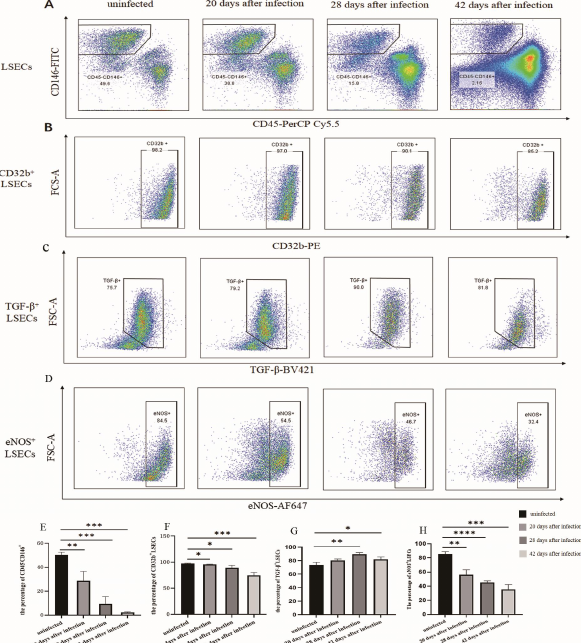
Figure 1. Changes in the LSEC phenotype after being infected with S. japonicum . ( A ) The population of LSECs in hepatic non-parenchymal cells after infection. ( B ) The population of CD32b + LSECs in hepatic non-parenchymal cells after infection. ( C ) The population of TGF- β + LSECs in he- patic non-parenchymal cells after infection. ( D ) The population of eNOS + LSECs in the hepatic non- parenchymal cells after infection. ( E ) Histogram showing the proportion of LSECs (CD45 - CD146 + ). ( F ) Histogram of the proportion of CD32b + LSECs. ( G ) Histogram of the proportion of TGF- β + LSECs. ( H ) Histogram of the proportion of eNOS + LSECs. * p < 0.05; ** p < 0.01; *** p < 0.001; **** p < 0.0001.